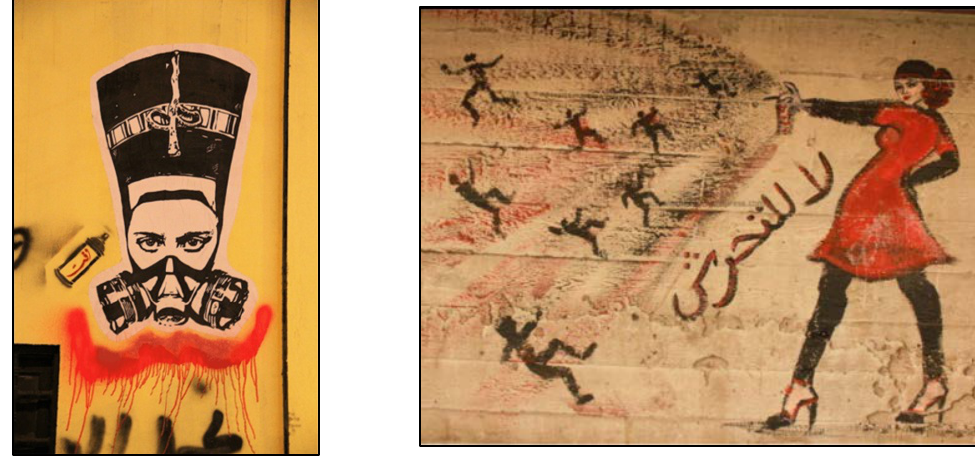
Figure7."Nefertiti"by El-Zeft Cairo, 2012 Figure8.graffiti by Mira Shihadeh